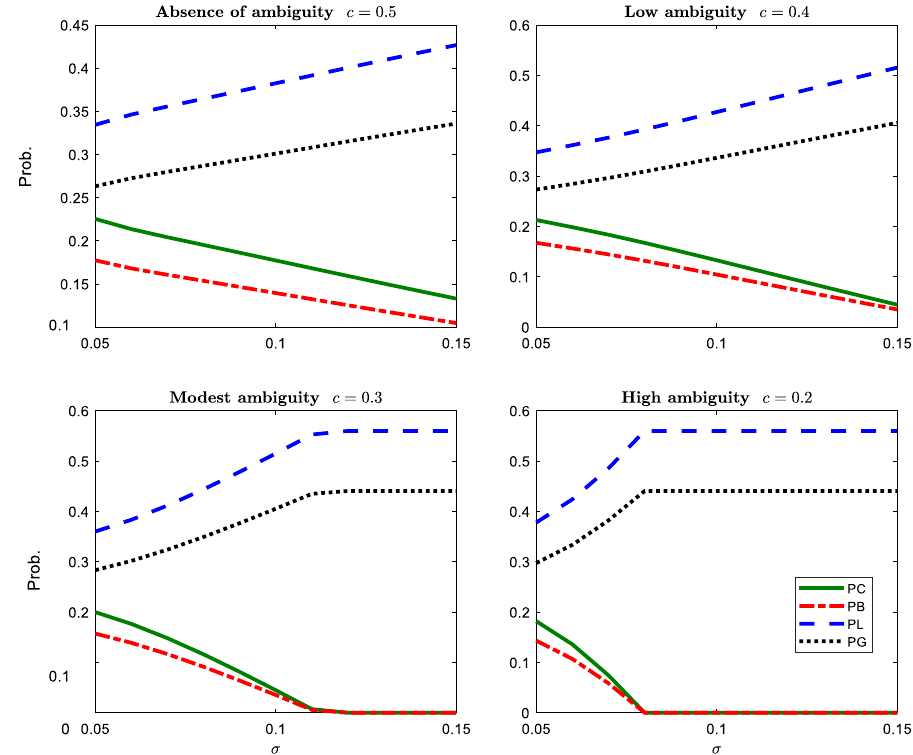
Fig. 6 Volatility impacts: Probabilities of the four strategies under ambiguity when the volatility of the state of innovation, σ , varies. PC , PB , PL , and PG represent the probabilities of pursuing compulsive, buy‑and‑hold, leapfrog, and laggard strategies, respectively. Parameter c represents the degree of ambiguity perceived by managers. When c = 0.5 , ambiguity is absent, implying that managers are neutral toward ambiguity. As c decreases, the degree of ambiguity increases. The case c = 0.2 represents the highest degree of ambiguity that managers perceive. When there is no ambiguity or the degree of ambiguity is low, PL and PG increase, but PB and PC decrease as the volatility of the state of innovation increases. When the degree of ambiguity is modest or high, the four probabilities remain constant beyond a certain level of